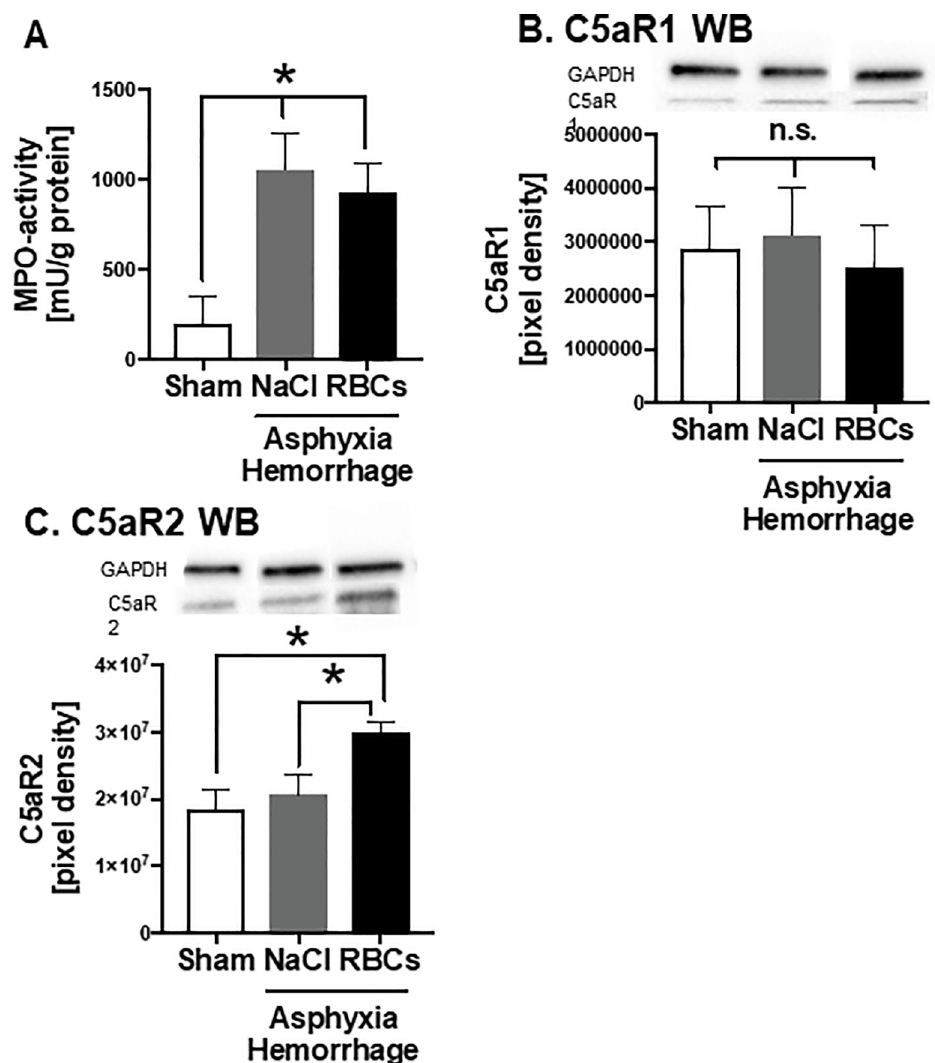
Fig 2. Local inflammation and activation of the complement system after AH. A) Myeloperoxidase (MPO) activity obtained from lung tissue samples. B) local amount of C5a receptor 1 and C) complement factor 5a receptor 2 protein in lung tissue normalized to the total protein amount of the samples, as well as representative western blots and loading control bands (GAPDH). � p = 0.05; n.s. = not significant, graphical representation as mean ± SEM, NaCl n = 6, RBC n = 9, sham n =